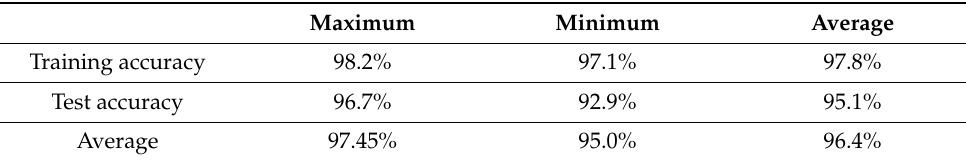
Table 4. Accuracy analysis of the TCN model architecture.